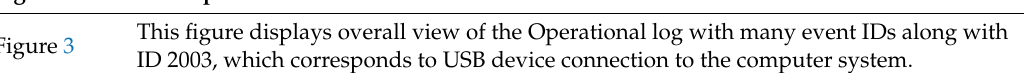
This figure displays overall view of the Operational log with many event IDs along with ID 2003, which corresponds to USB device connection to the computer system. This figure describes the information related to the Generic USB drive corresponding to event ID 2003 in the Windows Event Viewer. The figure clearly shows the USB device signature along with the log-in time, event ID number, log name, log level, category and the computer name. This figure describes the information related to the Kingston USB drive corresponding to event ID 2003 in the Windows Event Viewer. The figure displays the USB device signature along with the log-in time, event ID number, log name, log level, category and the computer name. This figure displays overall view of the Operational log with many event IDs along with ID 2102 which corresponds to USB device disconnection from the computer system. This figure describes the information related to the Generic USB drive corresponding to event ID 2102 in the Windows Event Viewer. Similar to Figure 3, it shows the USB device signature along with the log-out time, event ID number, log name, log level, category and the computer name. This figure describes the information related to the Kingston USB drive corresponding to event ID 2102 in the Windows Event Viewer. The figure displays the USB device signature along with the log-out time, event ID number, log name, log level, category and the computer name. The figure describes steps involved in the Create Custom View window of Windows Event Viewer. This figure displays the naming of the custom view filter. In our work, we named it as USB Flash Drive Connect-Disconnect Tracker. The figure displays the custom view sorted by event ID. The figure displays the custom view grouped by event ID for better